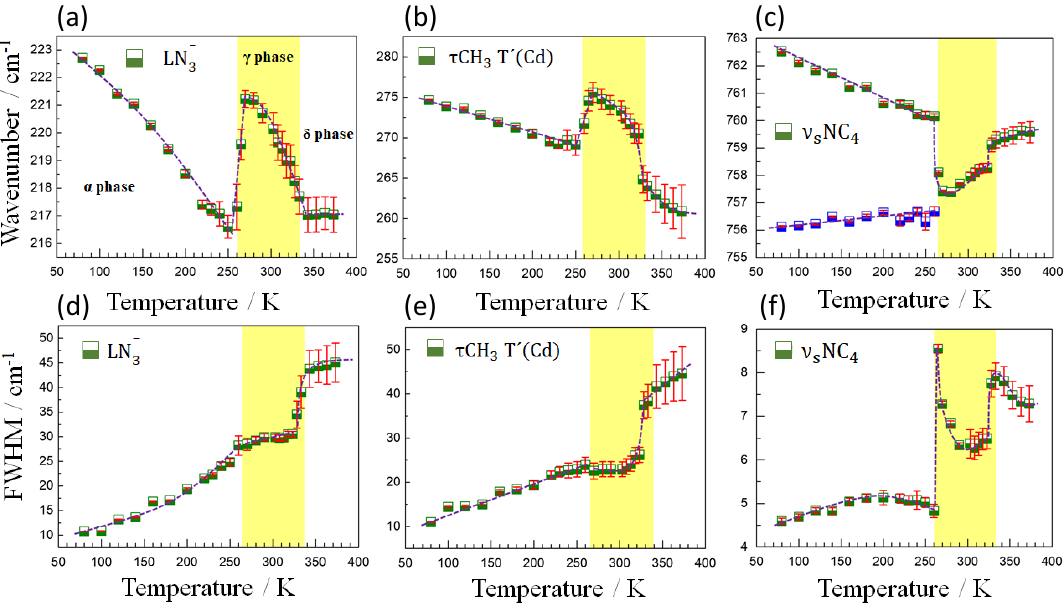
Figure 7. Temperature evolution of the wavenumber ( a – c ) and FWHM ( d – f ) of the most representative modes in the region of lower frequencies. The half-filled blue and green squares represent experimental data and the solid dotted purple lines represent eye guidelines. The solid vertical lines in red indicate the calculation error bar.